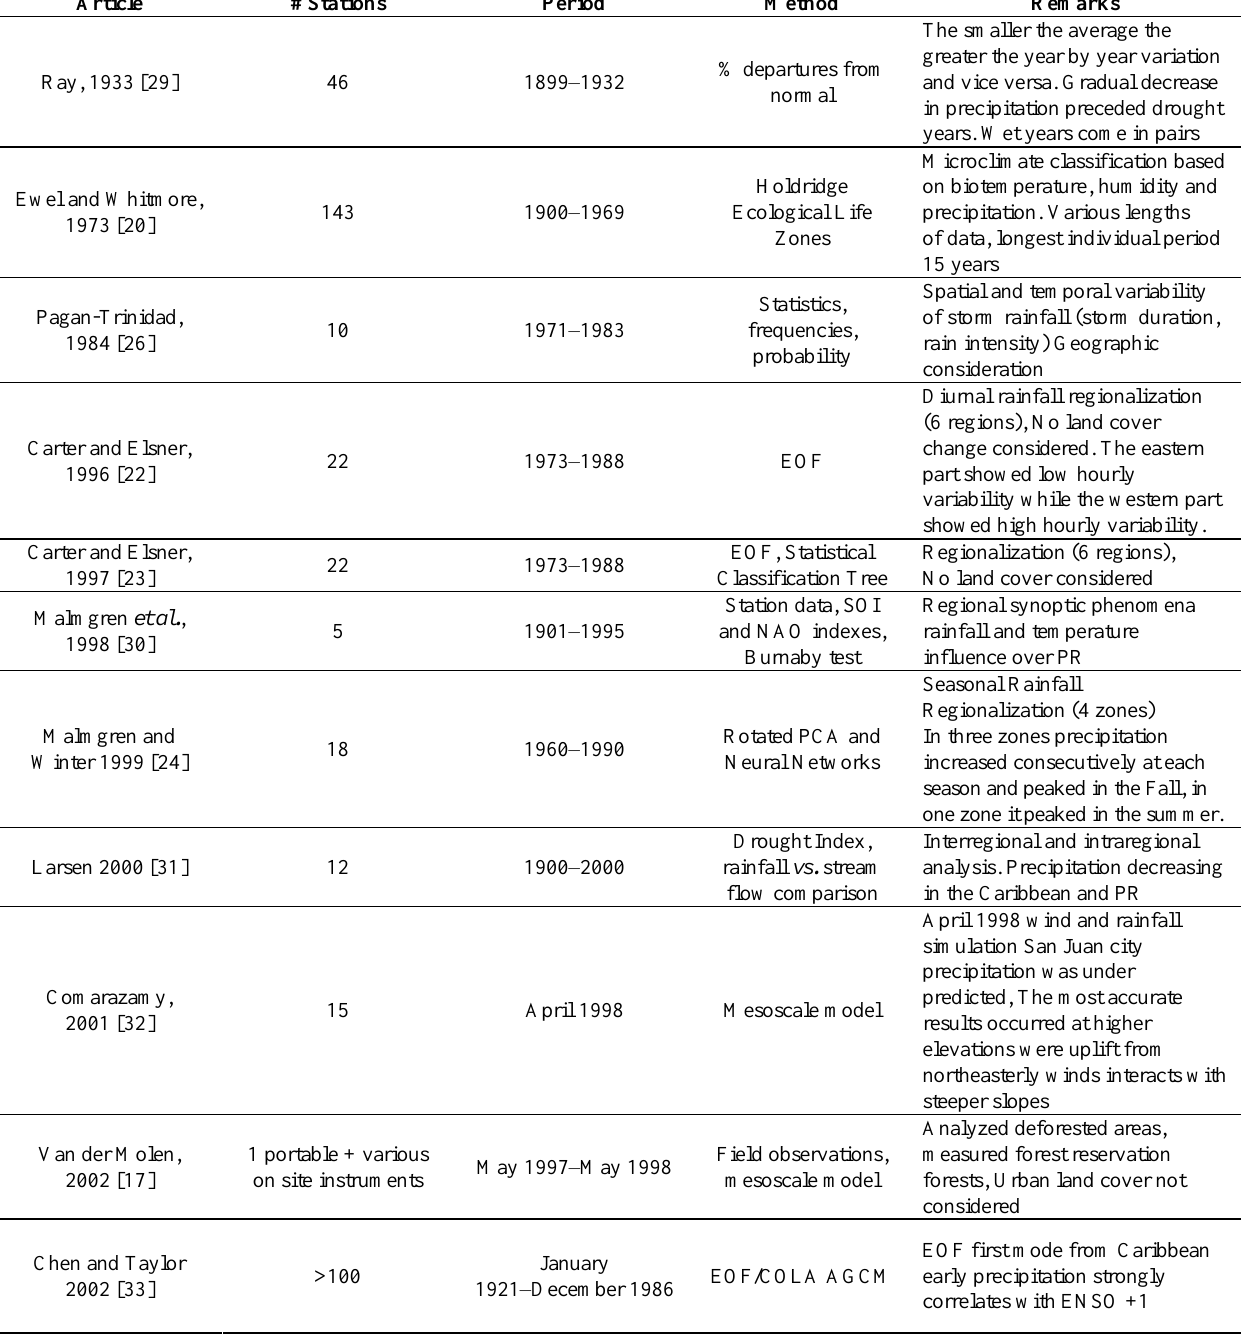
Table 1. Summary of previous published precipitation research for Puerto